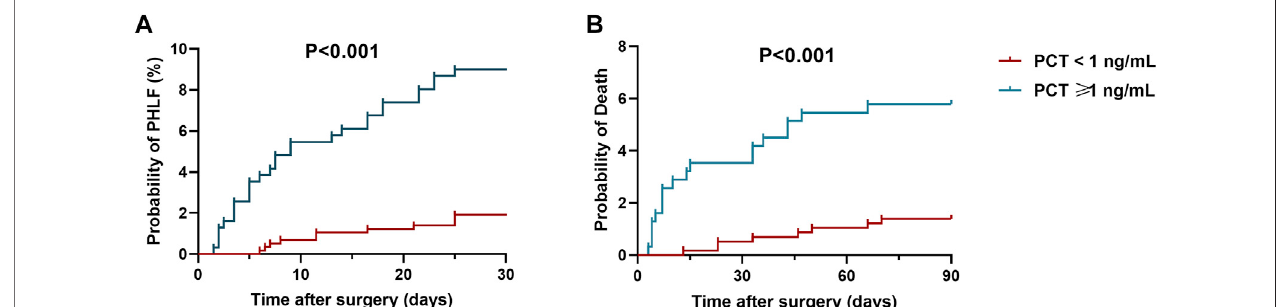
FIGURE 3 | Kaplan-Meier analysis for post-operative procalcitonin on (A) post-hepatectomy liver failure rate; (B) 3-month mortality.